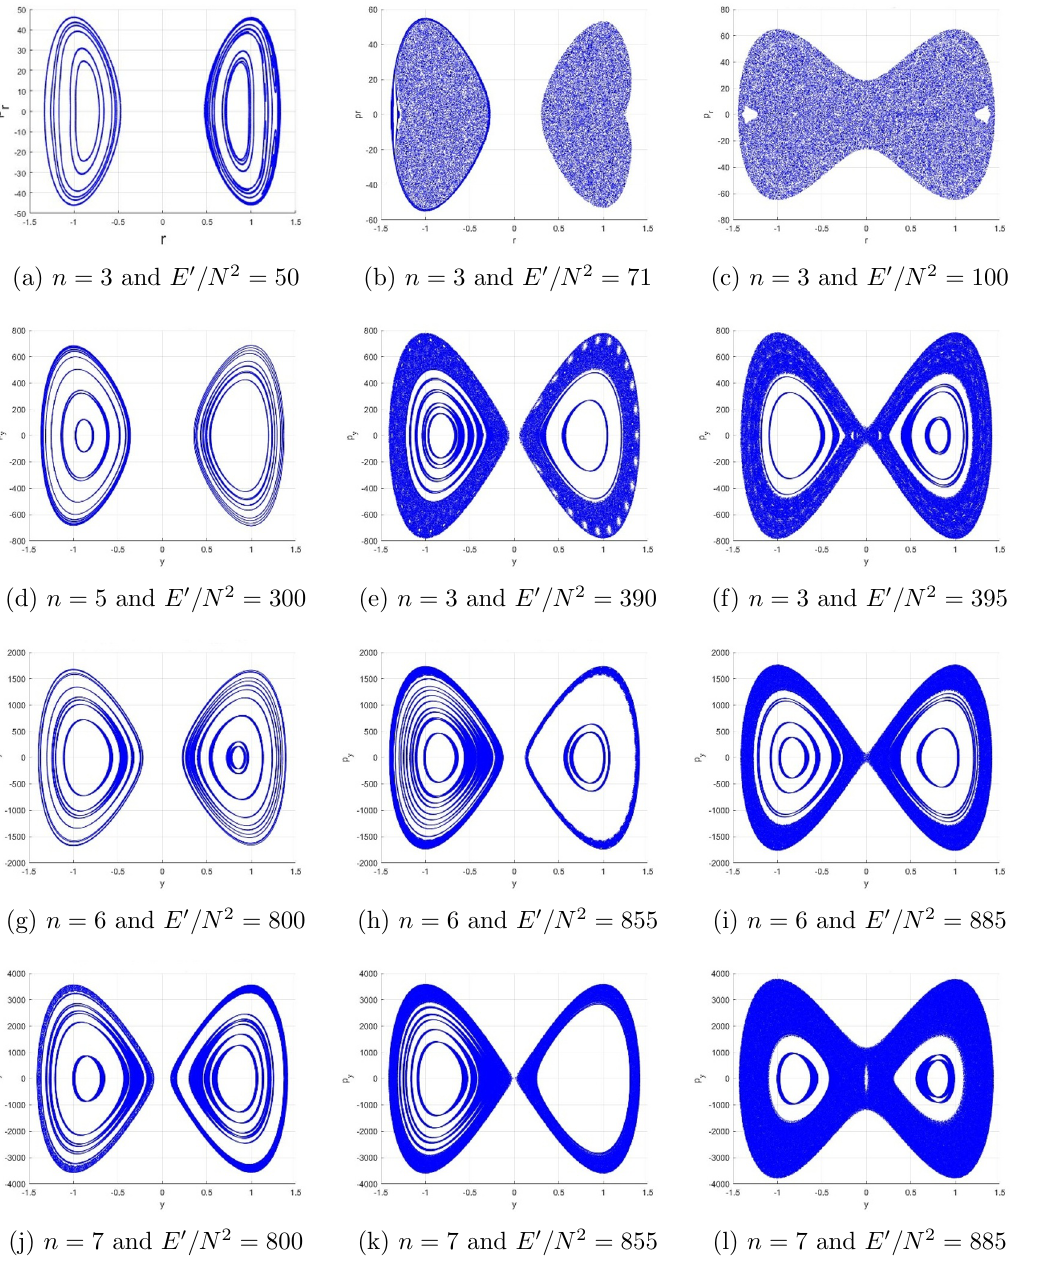
Figure 7. Poincar(cid:19)e sections at (cid:22) 2